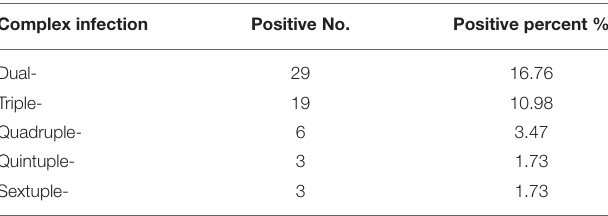
TABLE 4 | The co-infections of clinical samples from a longitudinal follow-up study in